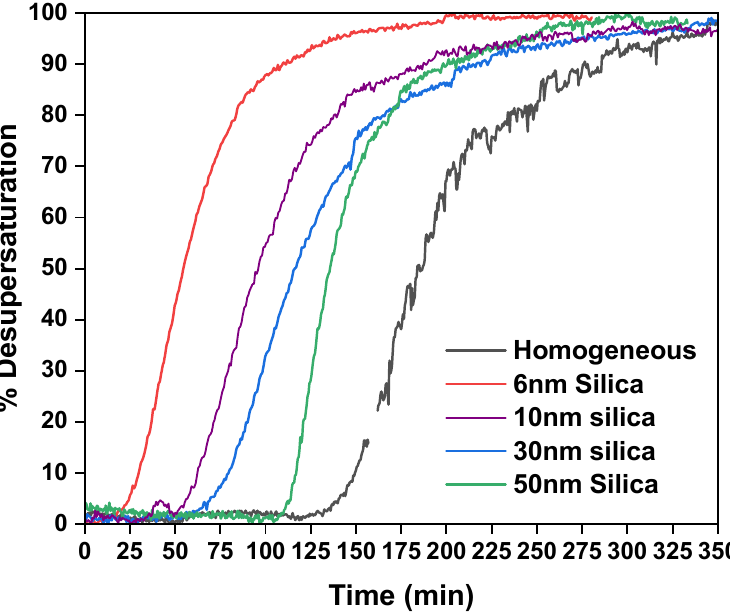
Figure 1. Comparison of % desupersaturation curves of diglycine in the absence and presence of porous silica at S = 1.20; volume = 40 mL; T sat = 40 °C; T cry = 32.7 °C.